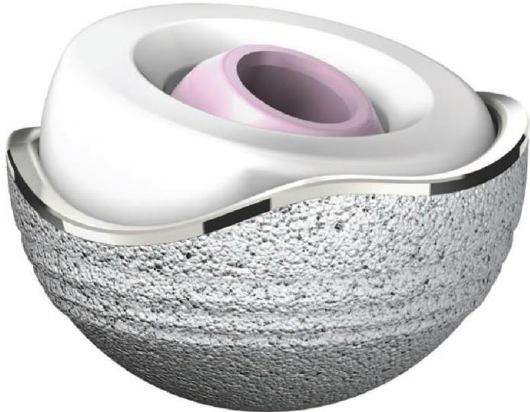
Figure 5. Anatomical design Dual-Mobility (ADM) X3 dual-mobility hip system. Courtesy of Stryker, Italia.